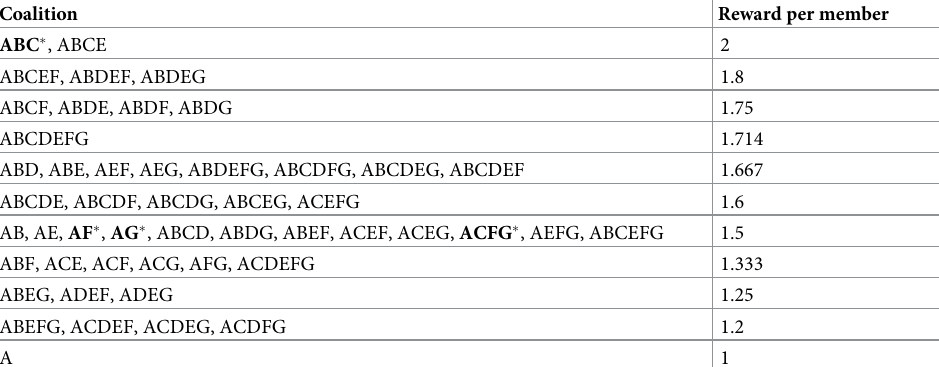
Table 4. Coalition preferences of the human player (A) in the game with the multiple core partitions.